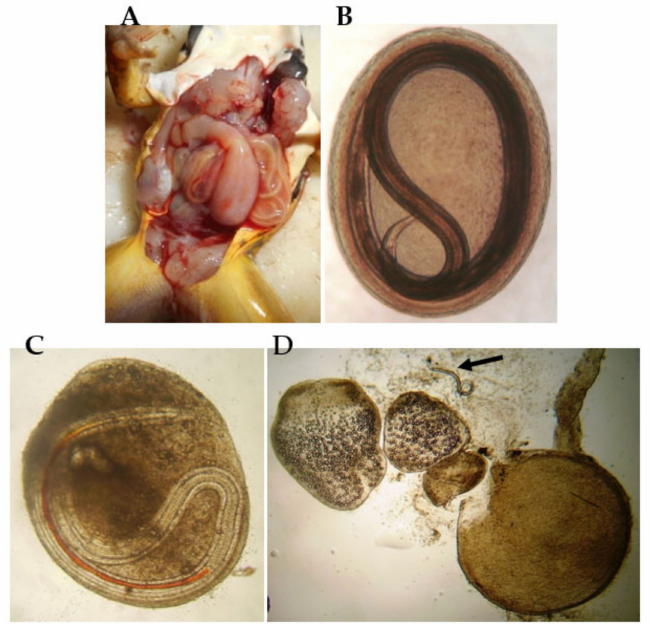
Figure 7. ( A – D ) Some nematode cysts occurring in anurans; ( A,B ) Ascaridod larvae in the body cavity of P . pumilio and stomach mucosa of H . occipitalis , respectively; ( C ) larva of an unidentified nematode infecting several anuran species; ( D ) an unidentified nematode larva occurring as mixed infection with Proteocephalus sp. larvae in a cyst recovered from S . tropicalis